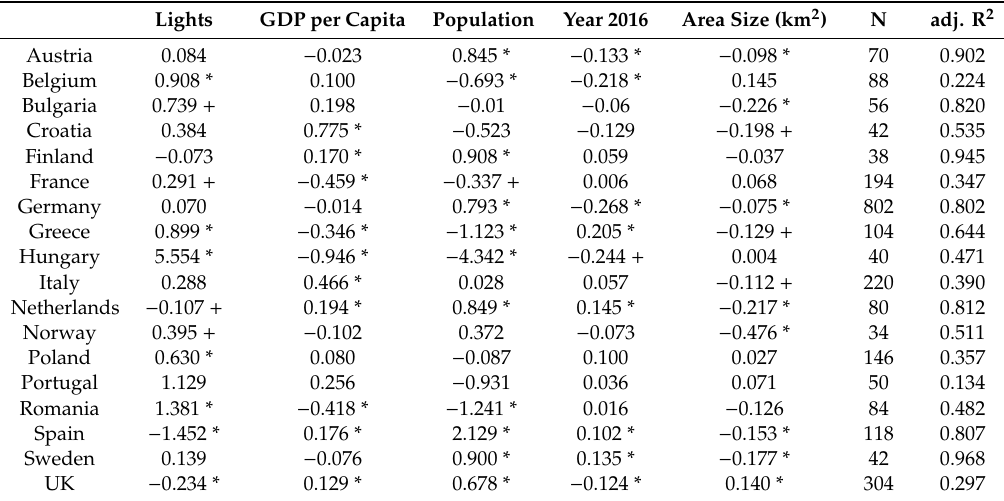
Table 2. Regression results for annual VIIRS composites, GDP per capita, and population.